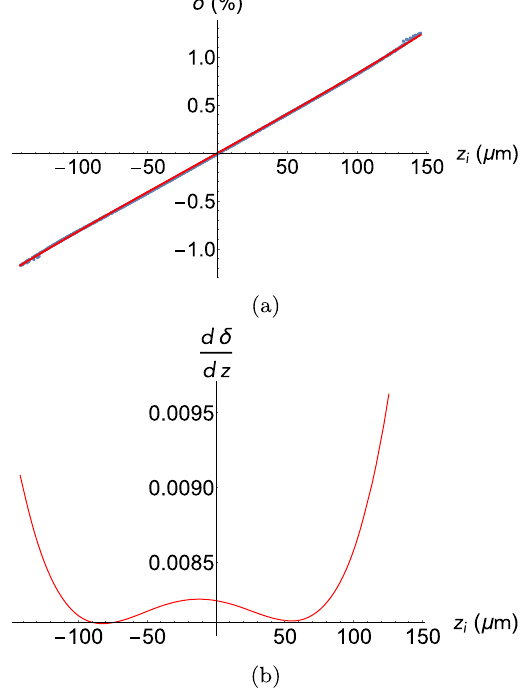
FIG. 4. (a) ELEGANT distribution taken before bunch compres- sor BC2, with a fit (thin, red curve), δ ¼ 81 . 06 z i þ 5929 . 08 z 2 i þ 1 . 30 × 10 8 z 3 i . (b) Derivative of polynomial fit emphasizing the nonlinearity of the